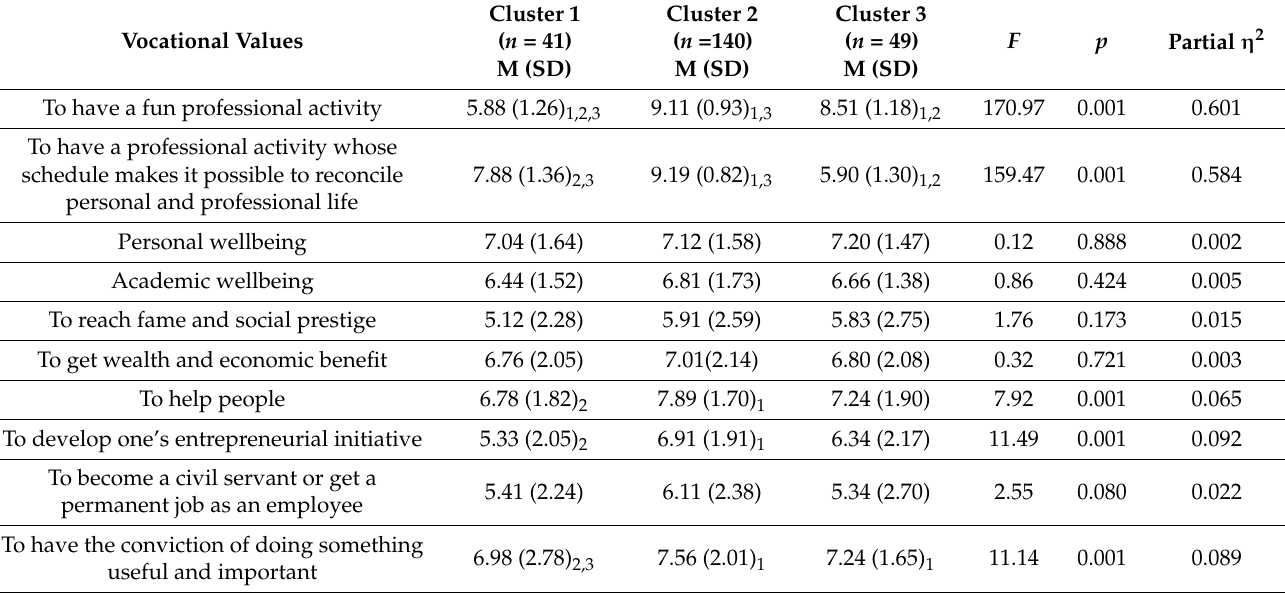
Figure 3. Mean clusters scores. Table 1. Differences in vocational values as a function of membership